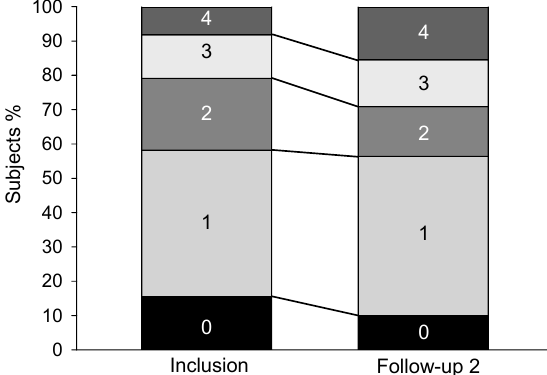
Figure 3. The modified Medical Research Council dyspnoea scale (mMRC) (ordinal scale 0–4) at inclusion and after two years.